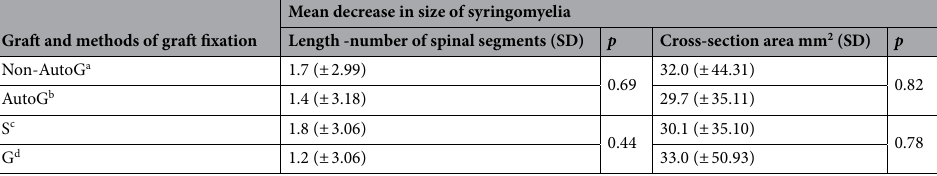
gomyelia decreased in 88.9% of the S group and 88.9% of the G group (Table 3). The cross-sectional area of the syrinx decreased to a similar extent regardless of the type of graft (p = 0.82) or the method of its fixation (p = 0.78). The mean length of syringomyelia decreased in a similar range (< 2 segments) depending on graft type (p = 0.69) and method of graft fixation (p = 0.44). The syrinx increased in 2 (3.7%) cases on follow-up MRI; both were in the Non-AutoG+S group (9.1%) (Table 4). Pseudomeningocele was present in 25 (35.7%) cases on follow-up MRI; however, it occurred significantly more frequently in the Non-AutoG group than in the AutoG group (52.4% vs. 10.7%; p < 0.05). Additionally, the rate of pseudomeningocele was similar in the G group compared with the S group (43.5% vs. 31.9%; p = 0.34). The rates of pseudomeningocele were 54.5%, 50.0%, and 12.0% in the Non-AutoG+S, Non-AutoG+G, and AutoG+S groups, respectively, and there were none in the AutoG+G group (p < 0.05). Correlations between duroplasty features and average thickness of pseudomeningocele are presented in Table 3. Seven (10.0%) patients had postoperative complications: 4 (9.5%) in the Non-AutoG group and 3 (10.7%) in the AutoG group (p = 1, see Table S1 in supplementary material). Five (7.1%) patients needed revision surgery, and 2 were conservatively treated for aseptic meningitis (1 patient, Non-AutoG) and purulent cutaneous fistula (1 patient, AutoG). In the Non-AutoG group, 3 (7.1%) patients were reoperated on for cerebellar subsidence, of whom 2 (4.8%) also had large pseudomeningocele and 2 (4.8%) had acute hydrocephalus. In all patients with complications in the Non-AutoG group, the graft was fixed with glue (Non-AutoG+G). In the AutoG group, two patients (7.1%) required revision surgery: 1 (3.6%) for symptomatic extradural hematoma and 1 (3.6%) for symptomatic pseudomeningocele. All patients with complications in the AutoG group had the graft fixed with sutures (AutoG+S, Tables 3 and 5). The risk of surgical revision for pseudomeningocele in the Non-AutoG, AutoG, S and G groups was 4.8%, 3.6%, 2.1% and 8.7%, respectively (Non-AutoG vs. AutoG: p = 0.81; S vs. G: p = 0.2). In the Non-AutoG+S, Non- AutoG+G, AutoG+S and AutoG+G groups, the risk of surgical revision was 0, 10.0%, 4.0% and 0, respectively (p = 0.34). Three patients with pseudomeningocele underwent repeat duraplasty with suturing of the graft. All 3 cases of cerebellar subsidence were treated by resection of one cerebellar tonsil and by optimization of craniectomy